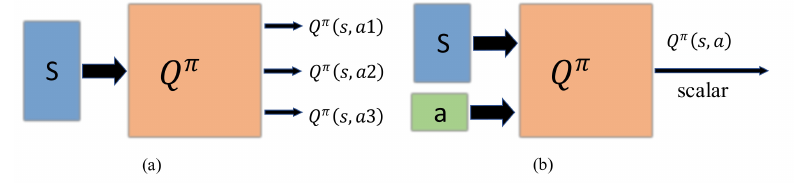
Figure 3. Q value mode ( a ) S − Q ( s , a n ) mode, ( b ) S , a − Q ( a )